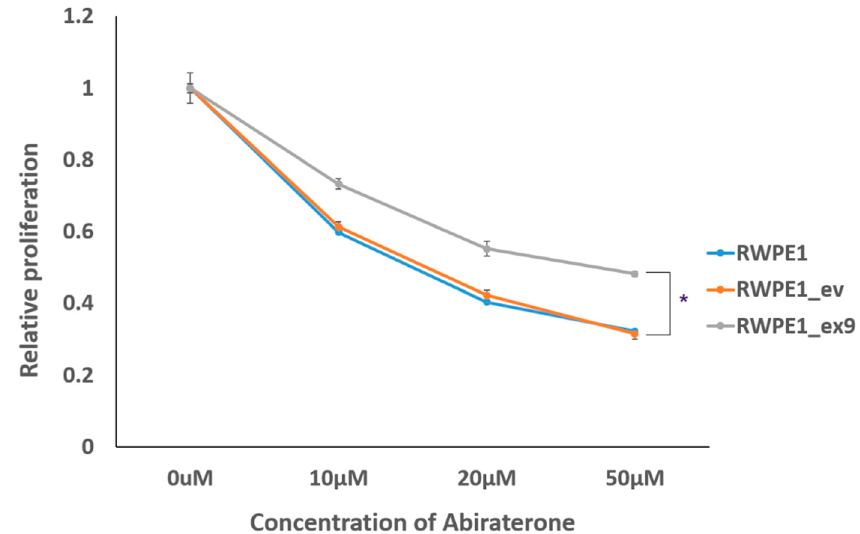
Figure 5. PVT1 exon 9 confers castration resistance. RWPE1_ex9 showed increased abiraterone resistance in comparison to RWPE1 or RWPE1_ev. Data are presented as mean +/ − standard error of the mean (SEM). Statistical di ff erences were determined with one-way ANOVA. All the criteria for significance were set at p < 0.05. Experiments were done three di ff erent times.